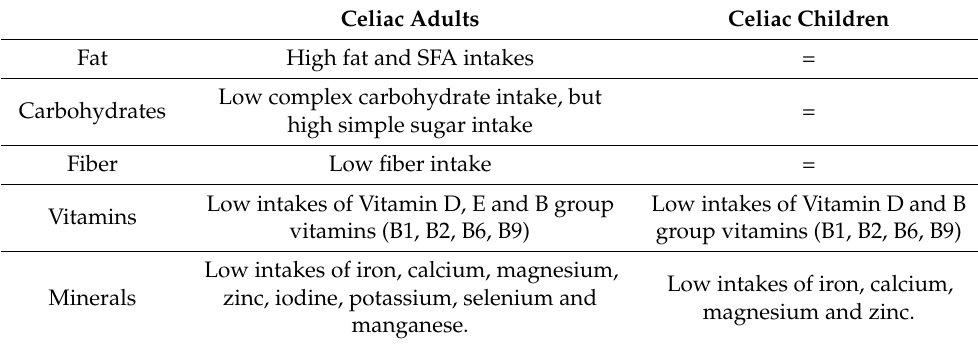
Table 3. Summary of nutritional deficiencies in celiac adults and children. Celiac Adults Celiac Children Fat High fat and SFA intakes = Low complex carbohydrate intake, but Carbohydrates = high simple sugar intake Fiber Low fiber intake = Low intakes of Vitamin D, E and B group Low intakes of Vitamin D and B Vitamins vitamins (B1, B2, B6, B9) group vitamins (B1, B2, B6, B9) Low intakes of iron, calcium, magnesium, Low intakes of iron, calcium, Minerals zinc, iodine, potassium, selenium and magnesium and manganese.